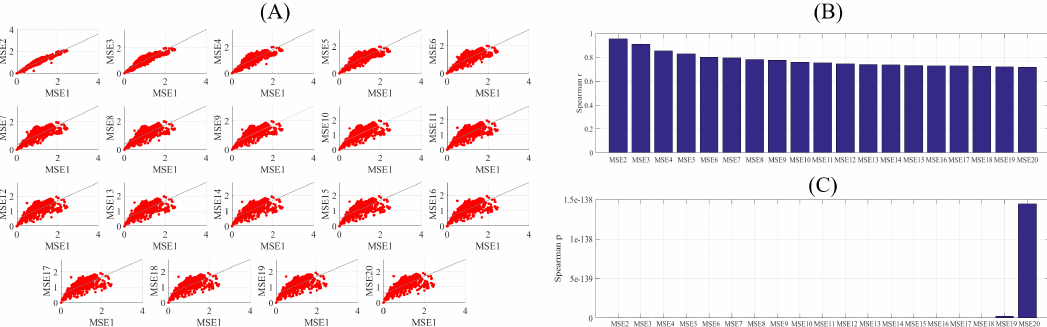
Figure A23. Negative affect’s Spearman correlations between MSE1 versus MSE2–MSE20. ( A ) Scatter plots of MSE1 versus MSE2–MSE20 ( B ) Spearman correlations associated with MSE2–MSE20 and MSE1 ( C ) Spearman correlations’ p -values associated with MSE2–MSE20 and MSE1.